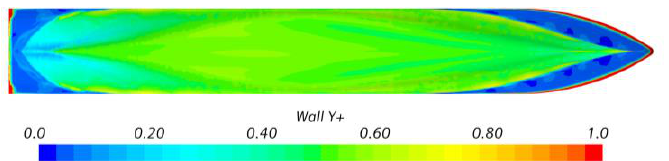
+ on the passing ship